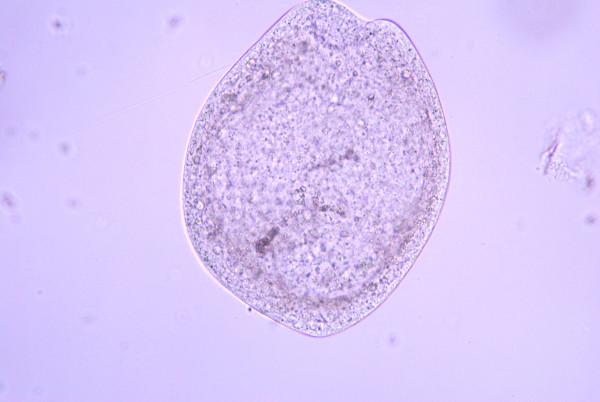
Developmental stage of a metacestode with well organized hooklets.